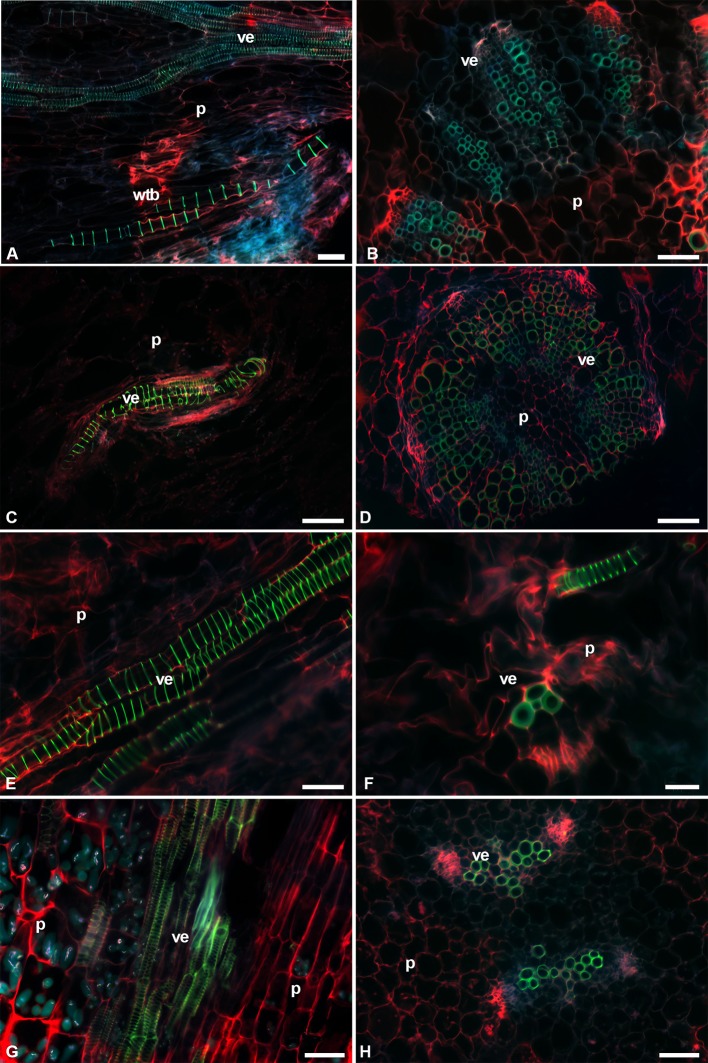
Image seedling stems of fibrous species with triple-band excitation fluorescence. (A, C, E, G) Longitudinal sections. (B, D, F, H) Transverse sections. (A, B)
Cylindropuntia imbricata. (C, D)
Lophocereus marginatus. (E, F)
Myrtillocactus geometrizans. (G, H)
Leuenbergeria lychnidiflora. Bar is 50 µm in (A, B, D, E, G, H); 100 µm in (C); and 20 µm in (F). p, parenchyma; ve, vessel element; wbt, wide-band tracheid.